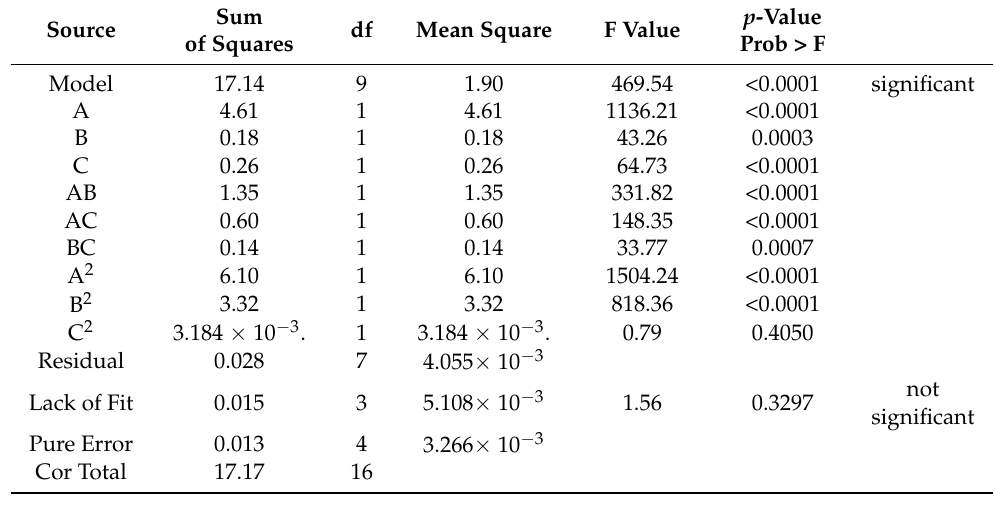
Table 7. Statistical analysis of variance for DL in Box–Behnken Design.